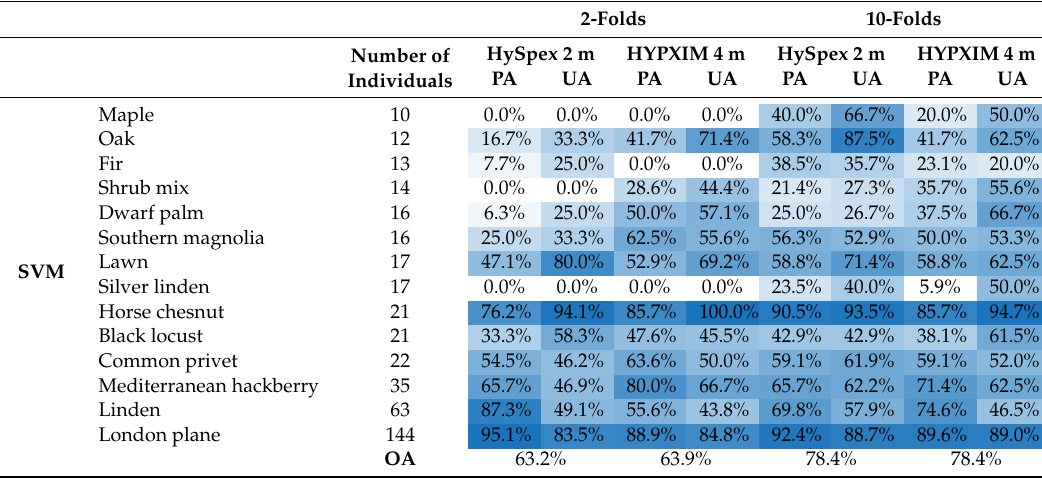
Figure 6. SVM classification of trees species (“14 Species” dataset) with MNF dimension reduction applied on HYPXIM at 4m. ( 1.a ) 2-folds method and ( 1.b ) Zoom on Grand-Rond roundabout; ( 2.a ) 10- folds method and ( 2.b ) Zoom on Grand-Rond roundabout.